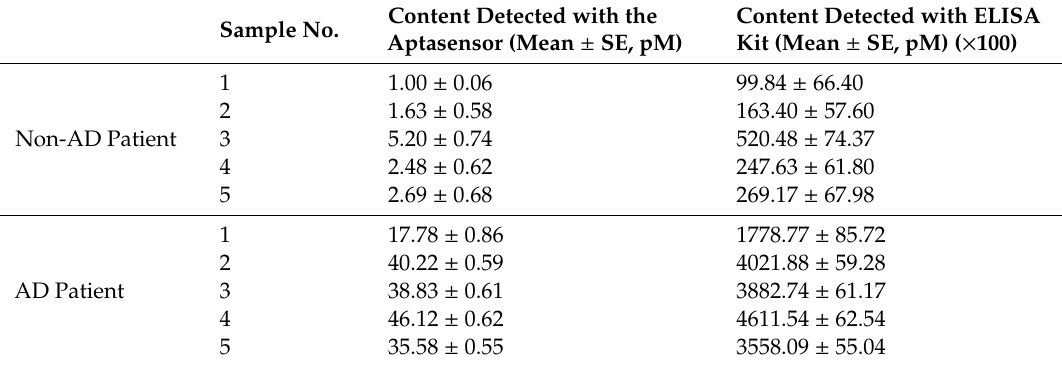
Table 3. Assay results of clinical serum samples using aptasensor.